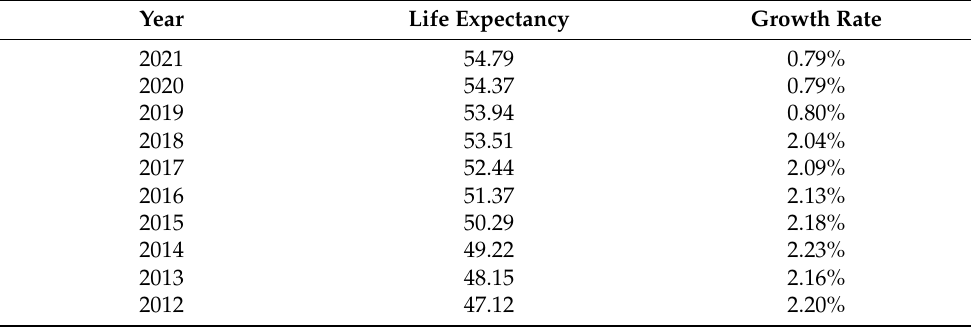
Table 1. The illustration of Lesotho life expectancy data